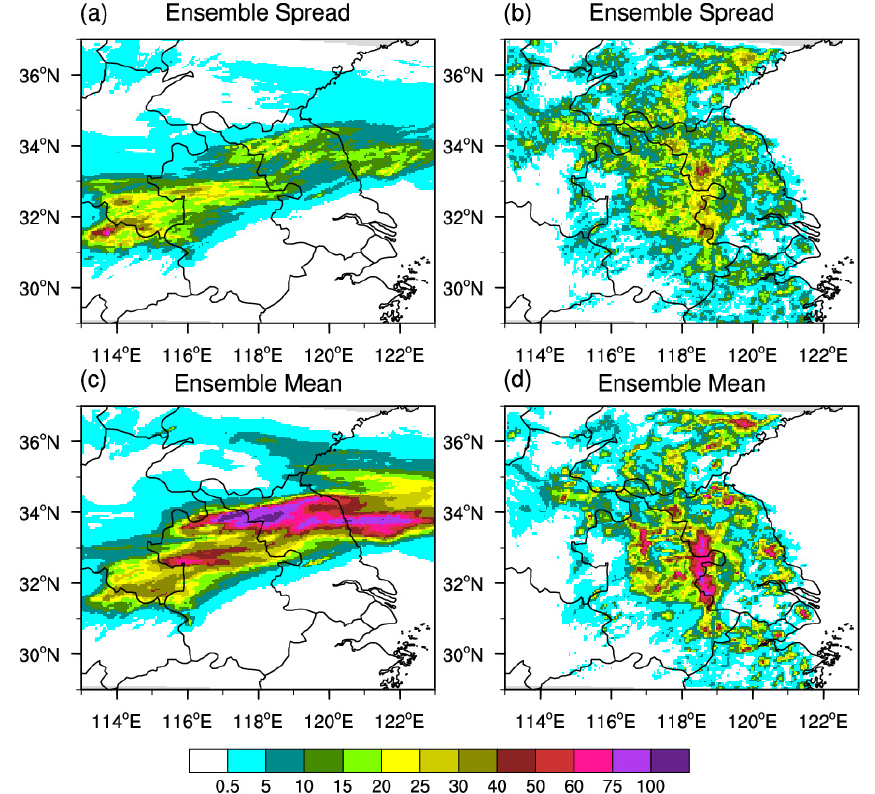
Figure 6. Spatial distribution of 12-h accumulated precipitation diagnostics (mm) for the LBP ensemble spread ( a , c ) and ensemble mean ( b , d ). Left column: the SF case, right column: the WF case. The precipitation time series (the first 4 h of spin-up ignored) in the major precipitation area is also an indicator of the great difference among the ensemble members